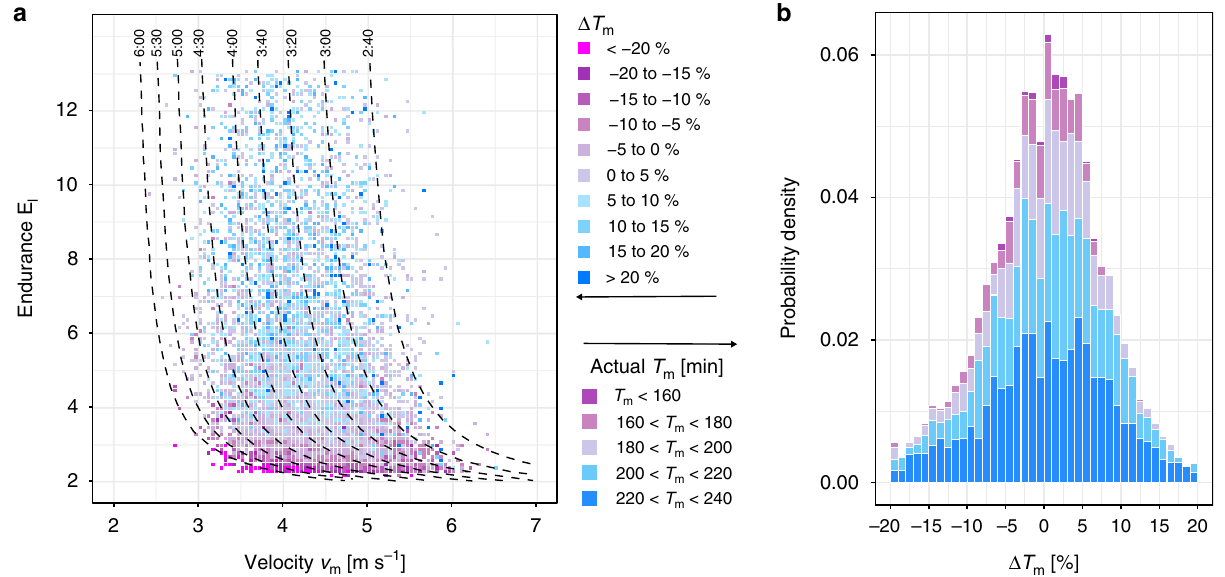
Fig. 4 Estimate of Marathon race time from the racing season (for 9410 seasons). a Visualization of the relative difference Δ T m between actual and estimated marathon race time T m (in percent of race time) as function of crossover velocity v m and endurance E l . Magenta (blue) color indicates a faster (slower) than estimated fi nish. b Probability density of race time differences color coded according to groups of different race time intervals.